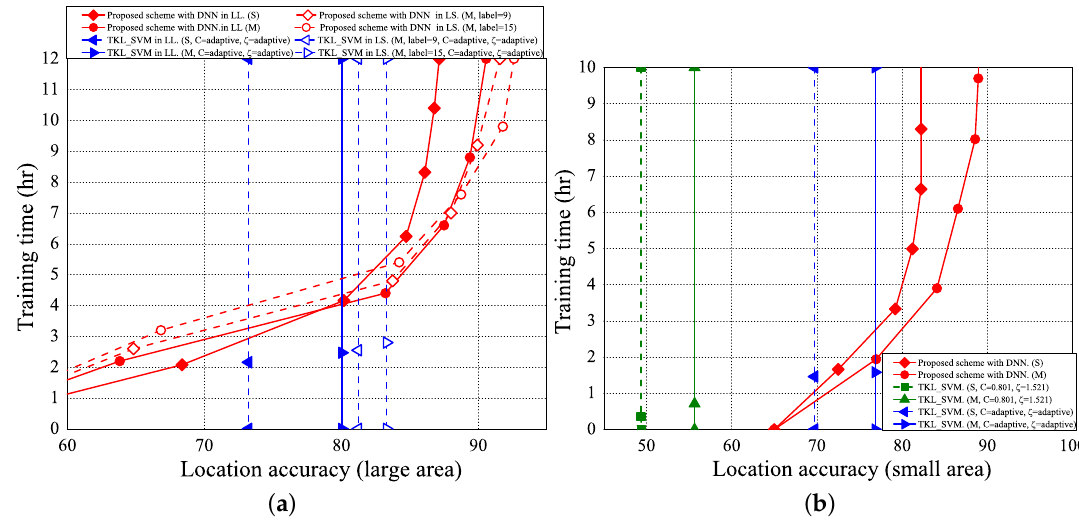
Figure 16. ( a ) The training time (LL,LS) vs. location accuracy; ( b ) the training time (SS) vs. location